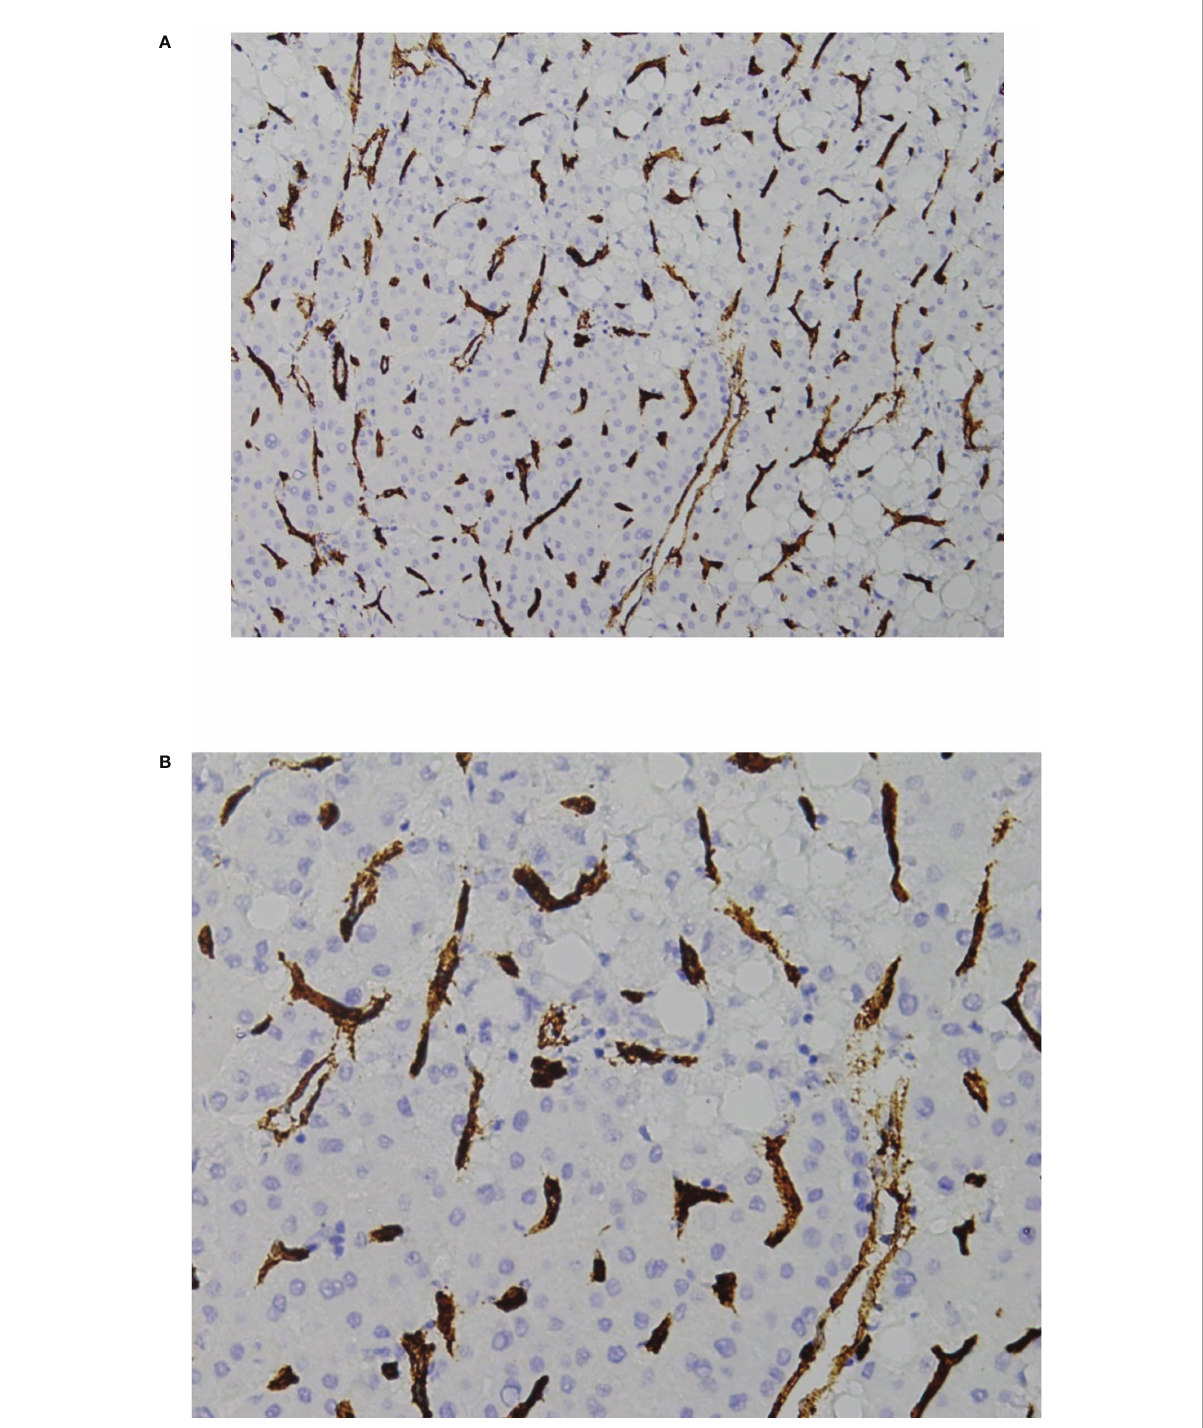
FIGURE 3 VETC-negative HCC. (A) 40X and (B) 200X view of the standard vascular pattern of sinusoidal capillarization seen in HCC. HCC, hepatocellular carcinoma; VETC, vessels that encapsulate tumor